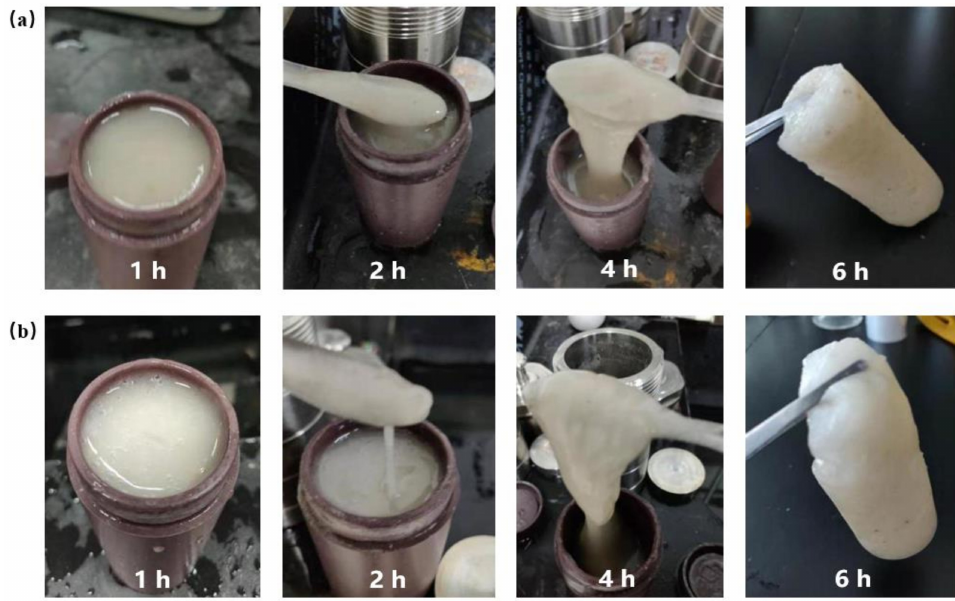
Figure 6. Gel morphology of low concentration initiator at different gelation times: ( a ) 0.1% initiator; ( b ) 0.2%